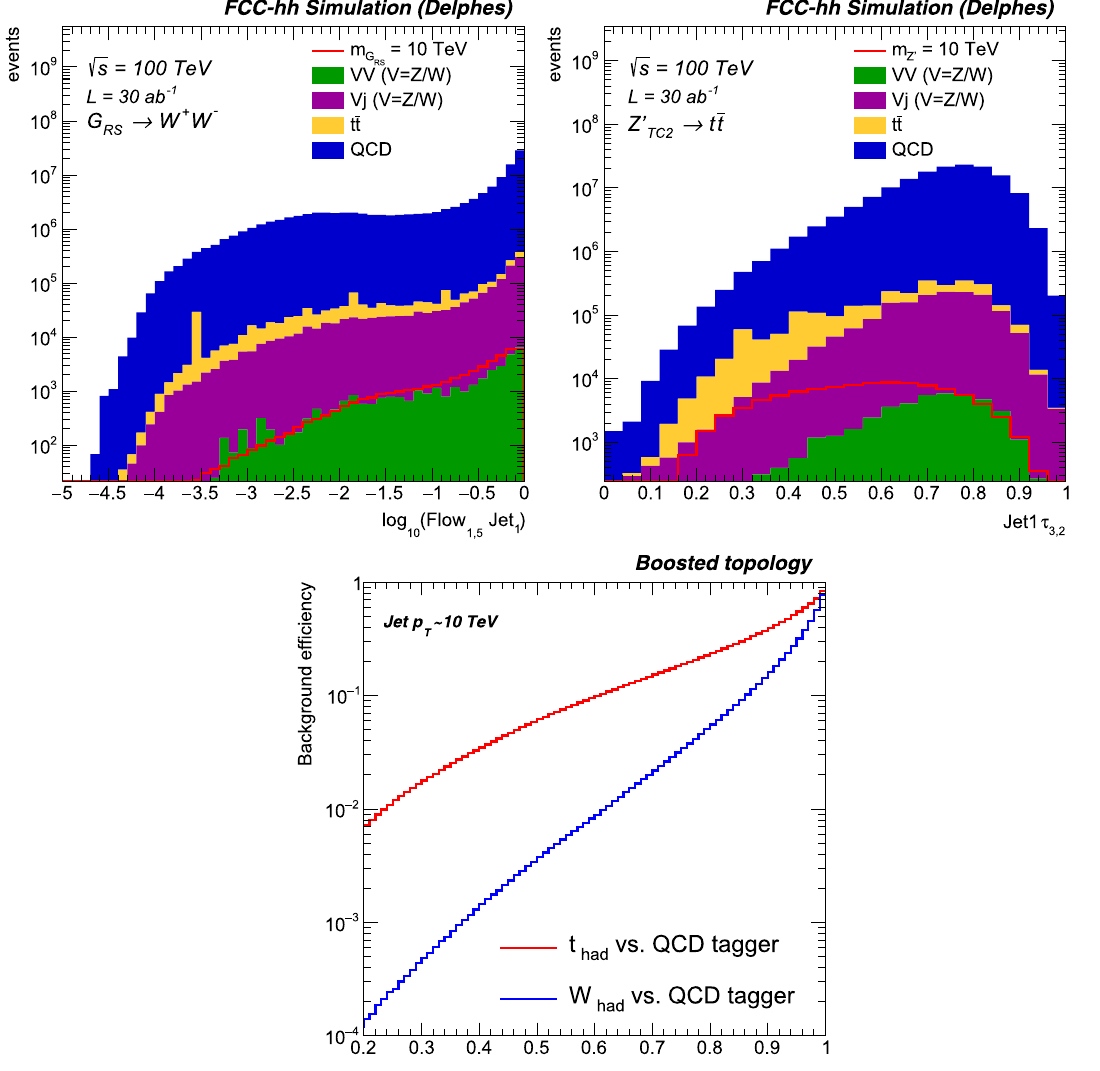
Fig. 15 Left: energy-flow E F ( n = 1 ,α = 0 . 05 ) observable for the leading jet p T of the G RS → W + W − analysis at the pre-selection level (two high p T jets). Right: τ 32 observable for the leading jet p T